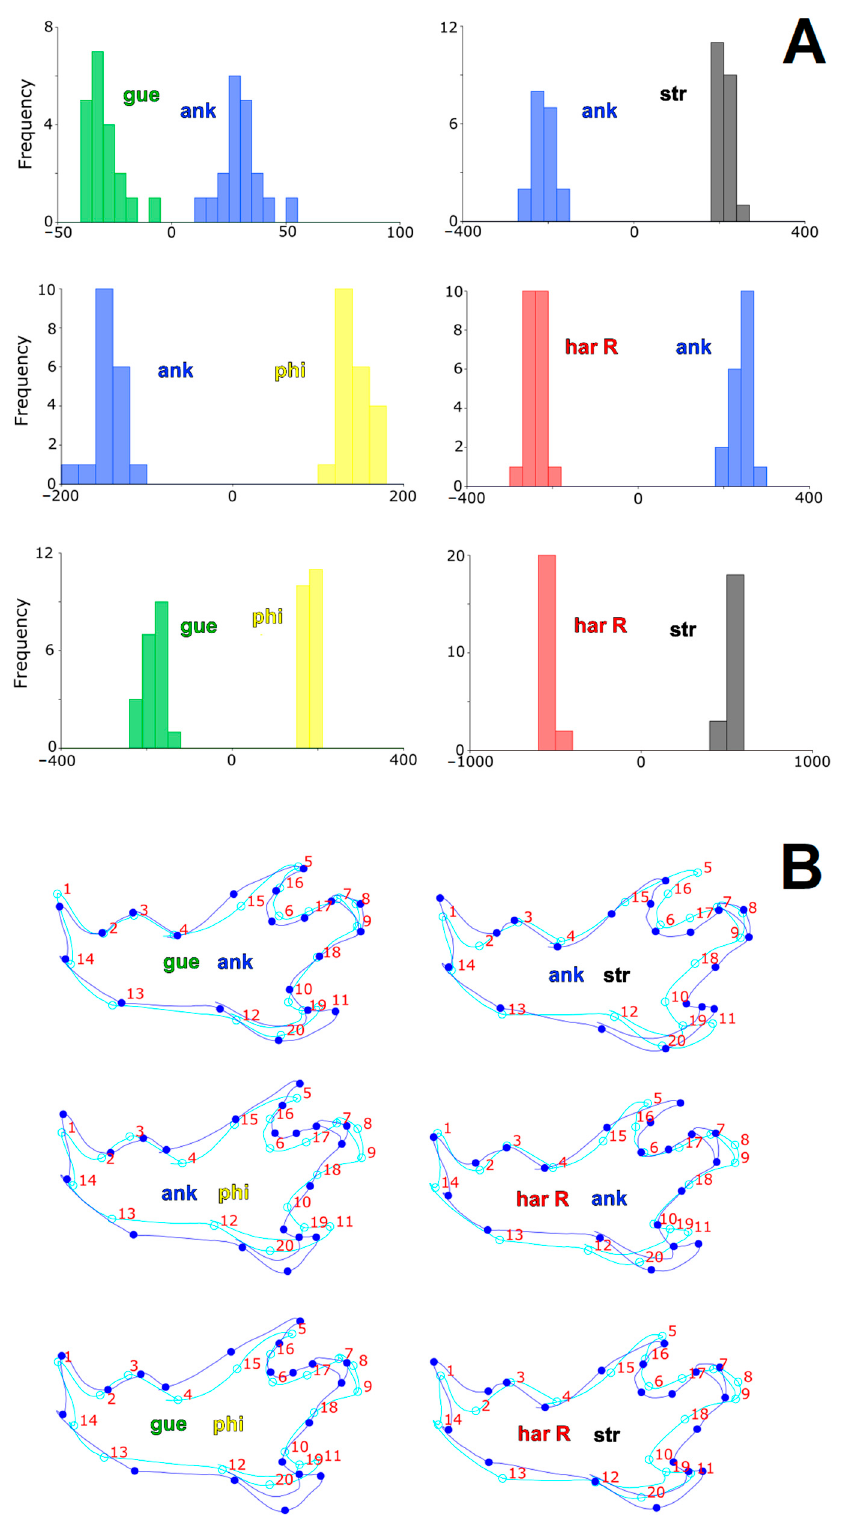
Figure 6. The DFA histogram ( A ) and shape ( B ) deformation results for mandible datasets from five vole forms in the “guentheri” group. Blue dots indicate landmarks after shape deformation; red numbers represent landmark numbers; the scale factor for deformation visualization: 4.0.